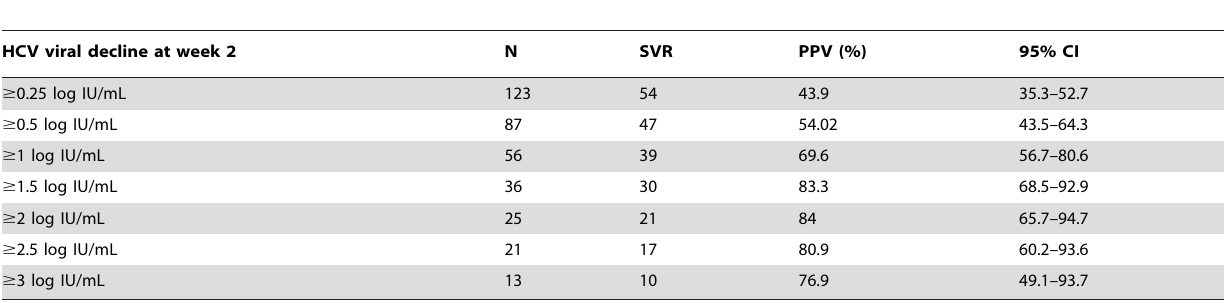
Table 2. Positive predictive value of HCV RNA viral decline at week 2 after starting therapy for sustained virological response (on- treatment approach, N =163).